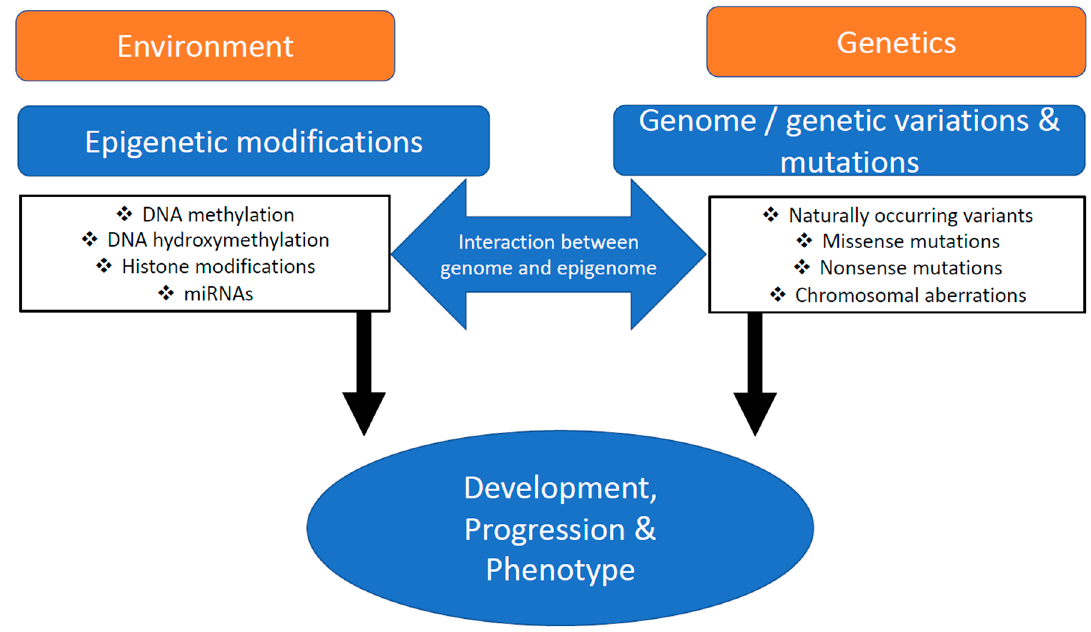
Figure 1. The interplay between inherited traits and environment. A combination of genetic markers and epigenetic effects determine the phenotype.